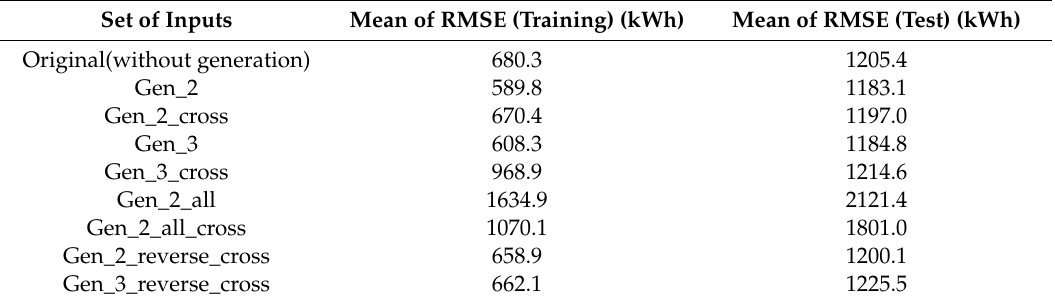
Table 5. Training and test